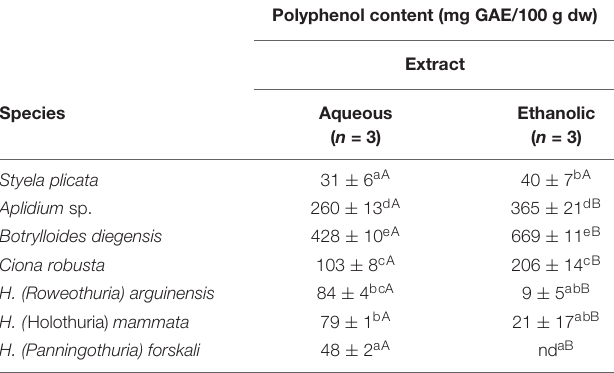
TABLE 1 | Polyphenol content (mg GAE/100 g dw) in aqueous and ethanolic extracts of the studied tunicates and sea